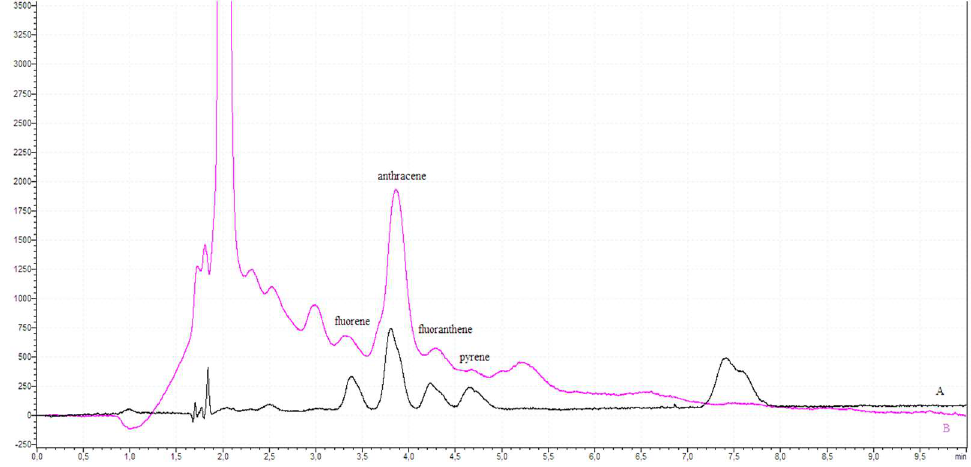
Figure 7. Sample chromatogram of the selected PAHs as detected in an environmental sample (B curve), in comparison with the standard solution (A curve).